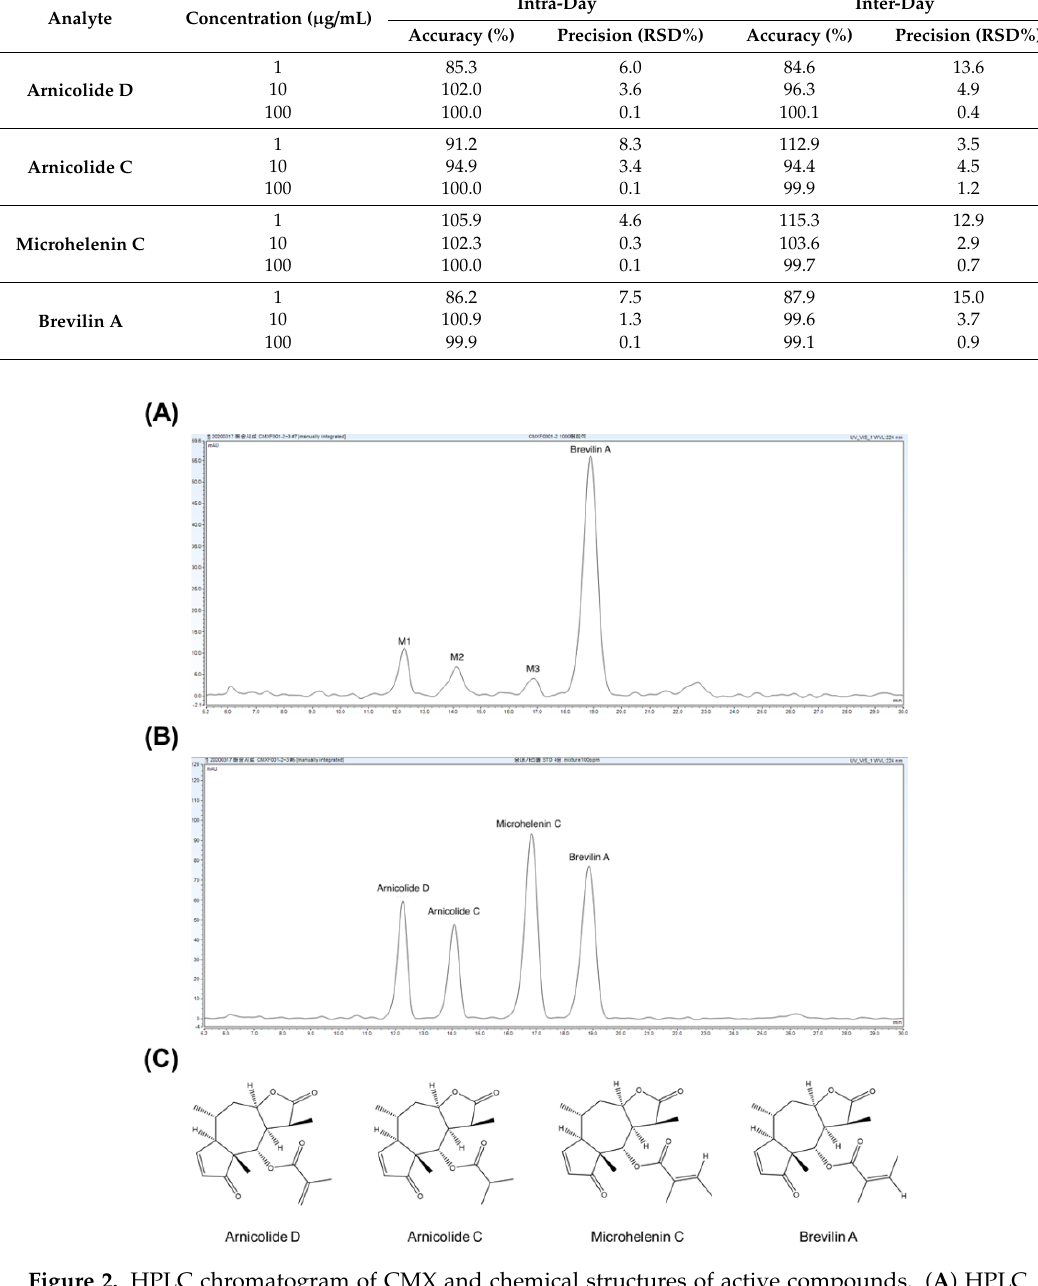
Figure 2. HPLC chromatogram of CMX and chemical structures of active compounds. ( A ) HPLC chromatogram of CMX sample. ( B ) HPLC chromatogram of standard mixtures of arnicolide D, arnicolide C, microhelenin C, and brevilin A. ( C ) Chemical structures of arnicolide D, arnicolide C, microhelenin C, and brevilin A. CMX, emulsion extract of brevilin A from Centipeda minima ; HPLC, high-performance liquid chromatography. Table 2. Chromatographic results and contents of CMX (n =